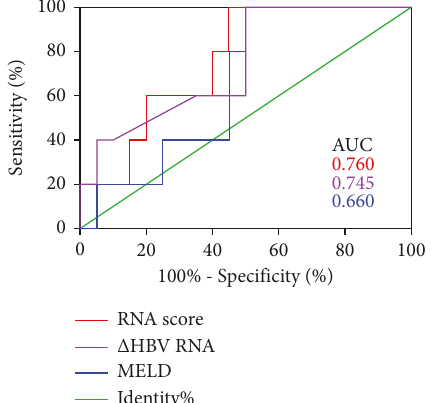
Figure 3: The serum HBV-RNA levels predicted clinical outcomes. The prognostic values of the serum HBV-RNA levels, MELD scores, and RNA scores were assessed by the ROC curves of the HBV-ACLF patients. The numbers represent the corresponding AUC.